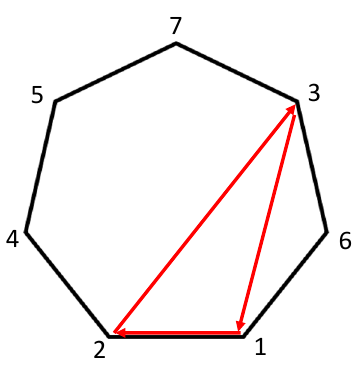
Figure 20 . The clockwise oriented heptagon for Cayley-Graves conventions. The order is in agreement with P CG = (1245736) . The first triad 123 is shown by red arrows. The second will be 246 as we can see from the figure, etc.